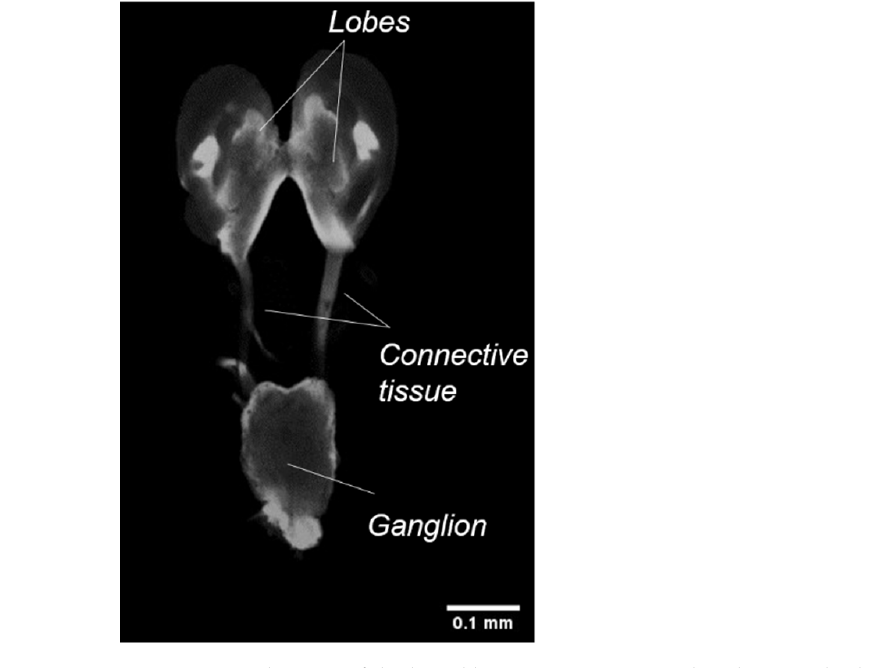
Figure 9. Visualisation of the larval brain, immunostained with an antibody against synapsin in a single confocal section, showing the lobes, connective tissues, and ganglion.